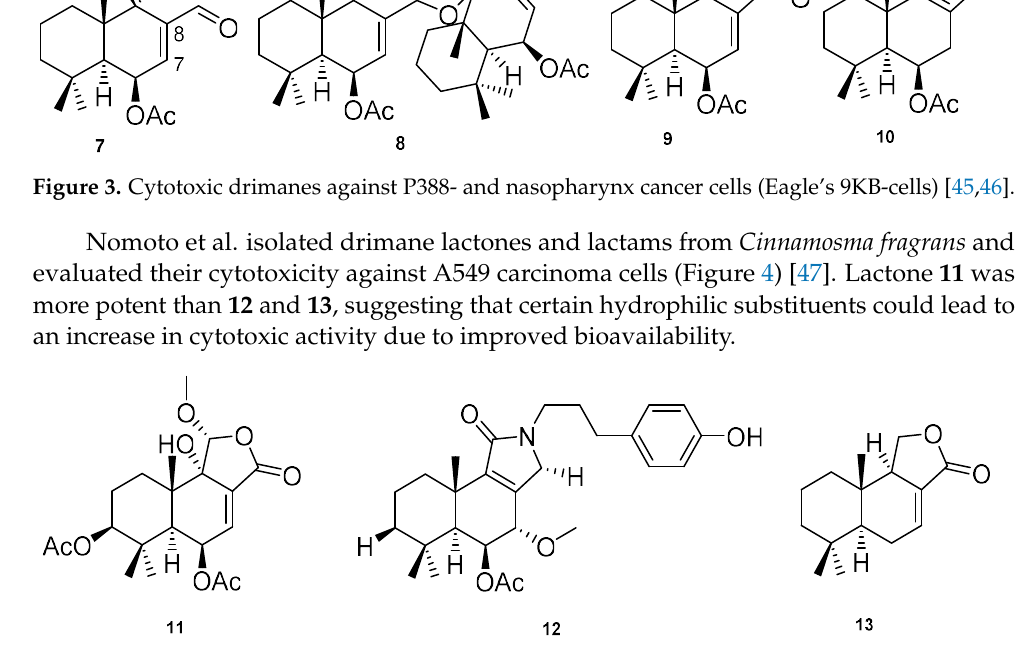
Figure 4. Cytotoxic drimanes from Cinnamosma fragrans against A549 carcinoma cells [47]. Fratoni et al. purified drimanes from the stem bark of Drimys brasiliensis and investigated their cytotoxic potential against leukemia cell lines K562 and Nalm-6 (Figure 5) [48]. The drimanes 14 – 19 and 2 were active against both cancer cell lines. Especially, the